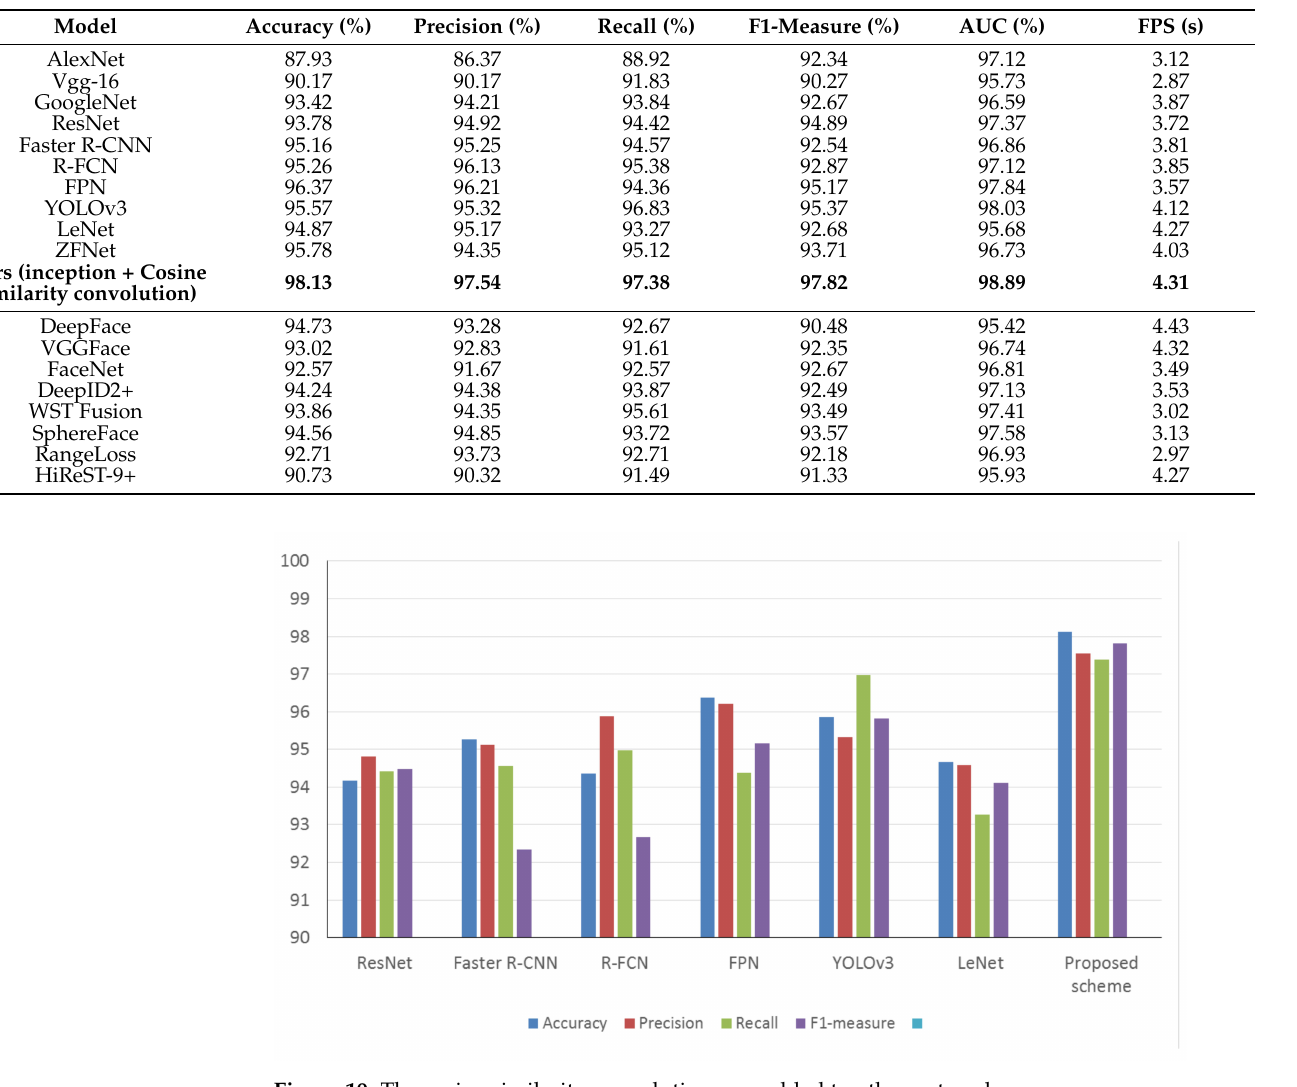
Figure 19. The cosine similarity convolution was added to other